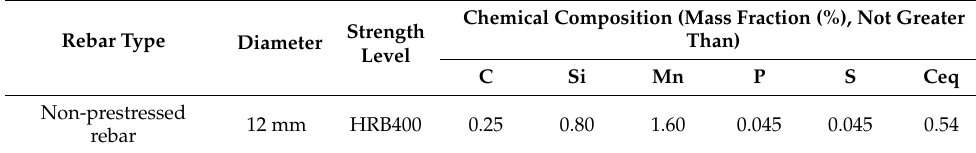
Table 3. Chemical compositions of the non-prestressed reinforcement. Rebar Type Diameter Strength Level